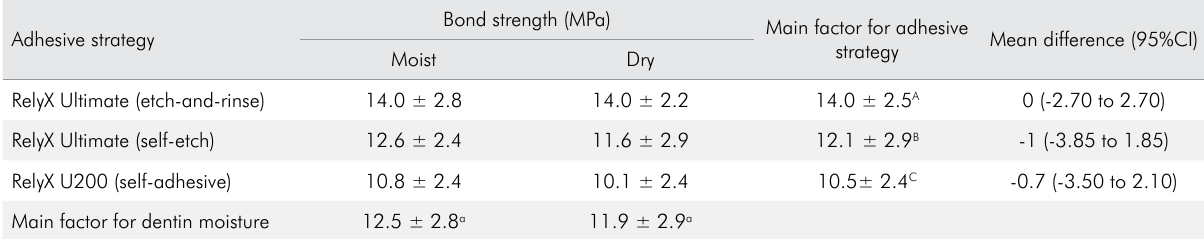
Table 1. Means, standard deviations, and mean differences for push-out bond strength (MPa) Adhesive